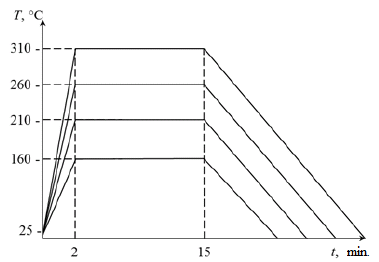
Fig. 4. Thermal profiles of post-processing of experimental